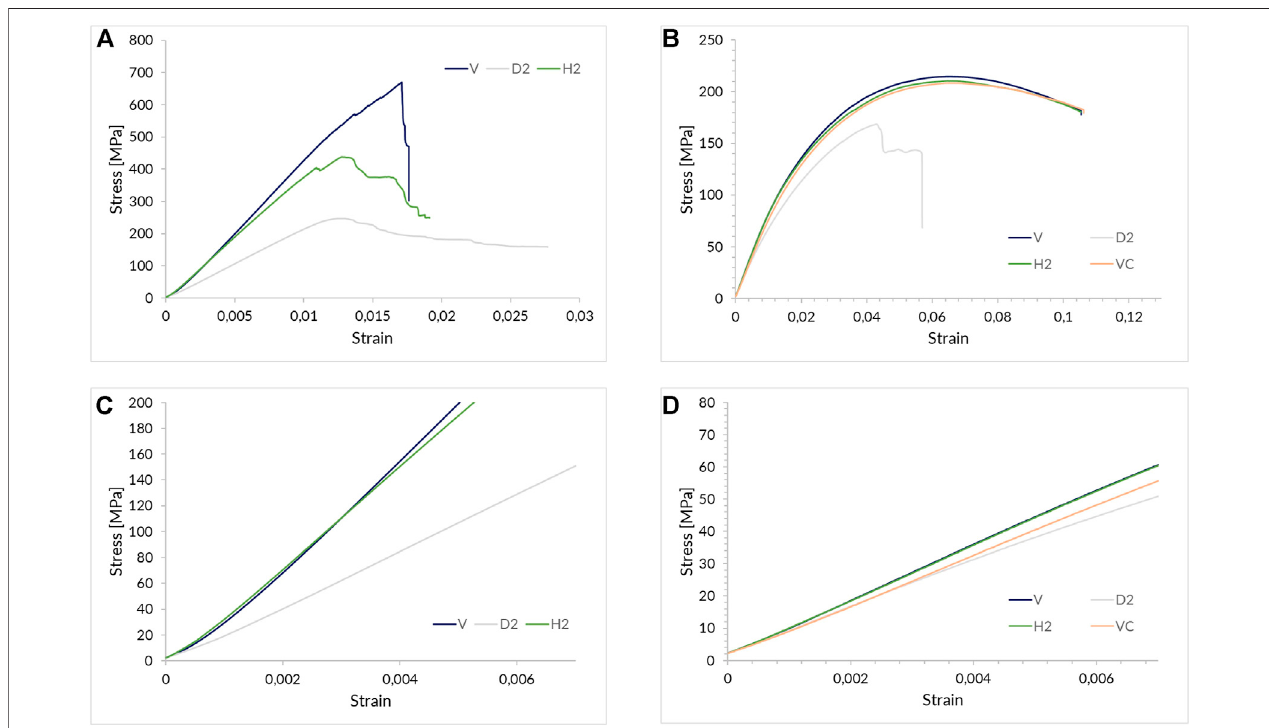
FIGURE3| Examplesof3-pointbendingtestcurvesfor (A) [(0/90)] 18 V,D2,andH2samplesand (B) [(+45/-45)] 18 V,VC,D2,andH2samples. (C) and (D) depicta zoom on the curves ’ areas representative of the fl exural modulus, respectively, for samples with fi bers oriented at 0/90 ° and ±45 ° .